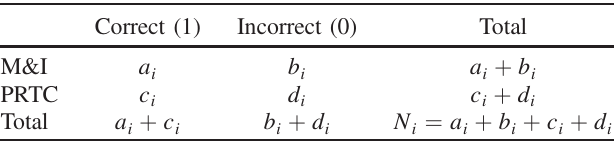
TABLE I. A cross-table showing student success and failure frequencies on an item at the i th stratum measured by the FCI total scores in each